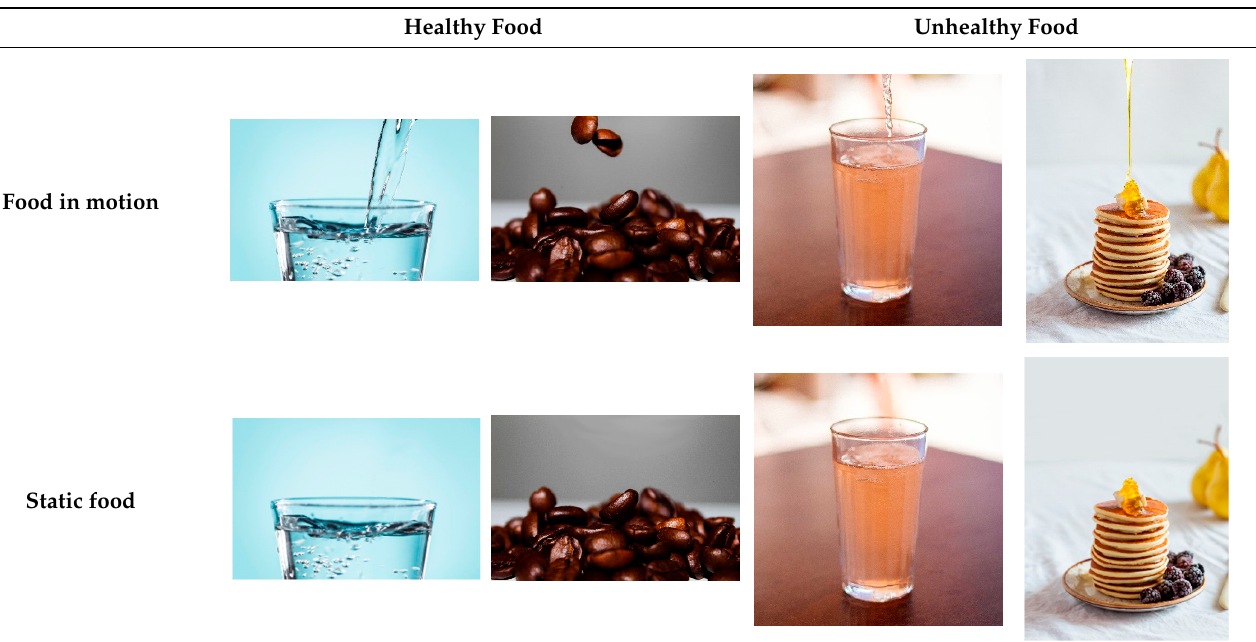
Table 2. Examples of the food stimuli used in Study 1.